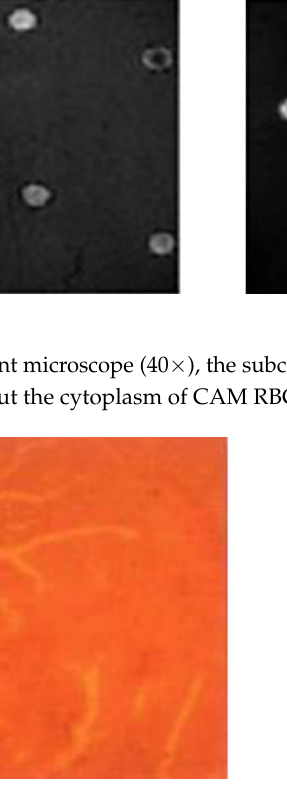
Figure 2. The PDT-induced vascular damage was evaluated, and observable damage with vascular constriction or occlusion was evaluated under a stereomicroscope. The area where the blood vessel color turns white represents the vascular damage induced by PDT (right-hand side). In contrast, the area where the blood vessel color remains unchanged as a control represents the vascular tissue not damaged by PDT (left-hand side).